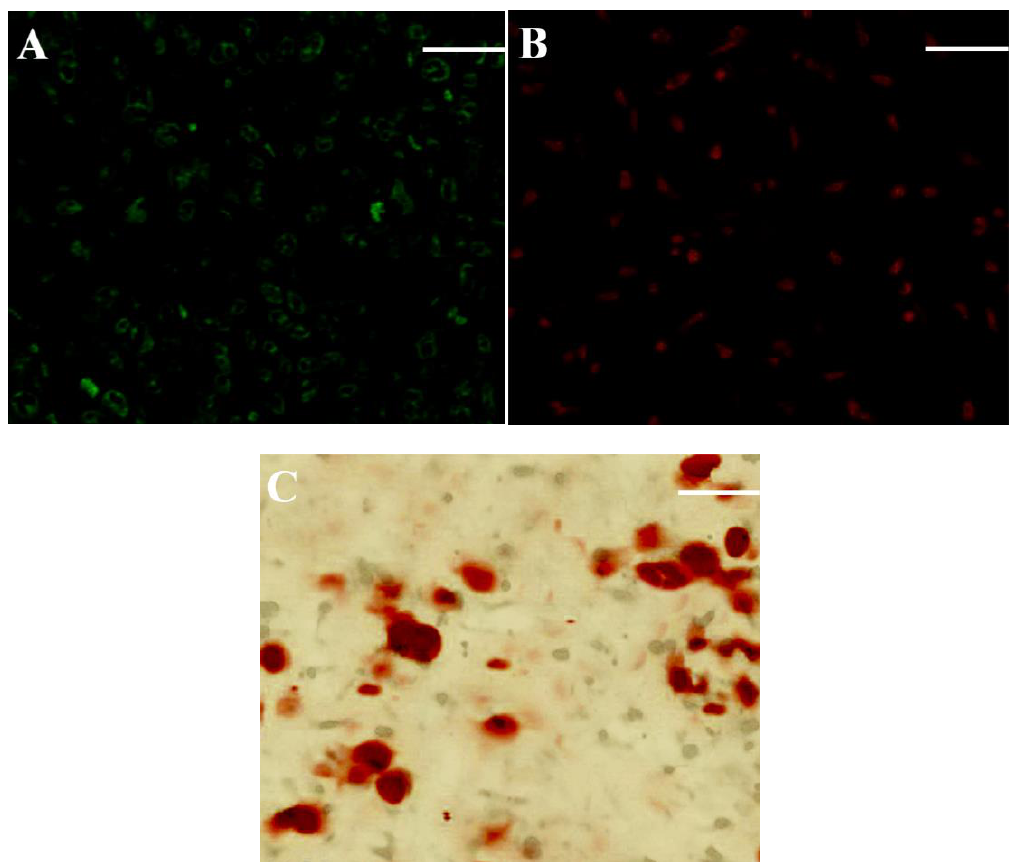
Figure 6. Typical staining micrographs for sections vertically cut from chondral layer ( A ) and bony layer ( B , C ) of cell-seeded scaffold ( A , Immunofluorescence staining for type-II collagen; B , Immunofluorescence staining for type-I collagen; and C , Alizarin red staining for calcium deposition; culture time: three weeks; Scale bar, 100 μ m).